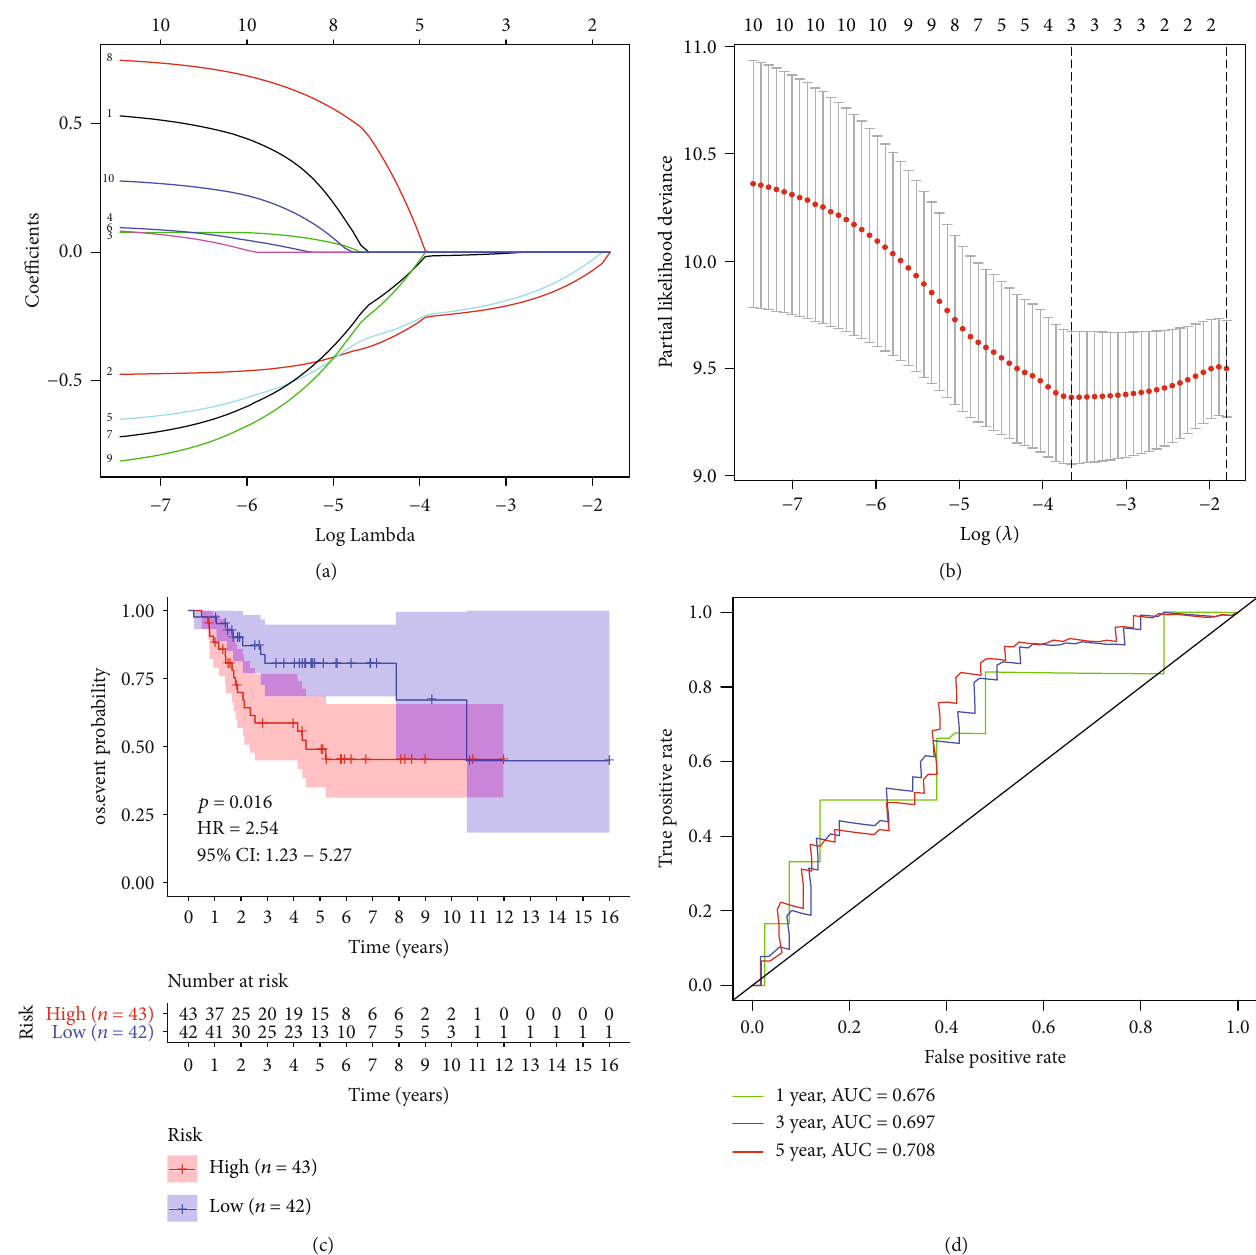
Figure 4: The results of the Cox prognostic model and veri fi cation. (a) Determine parameter Lambda in LASSO. (b) Crossvalidation determination Lambda. (c) Survival analysis between high- and low-risk groups in TARGET. (d) The result for the ROC curve of the TARGET